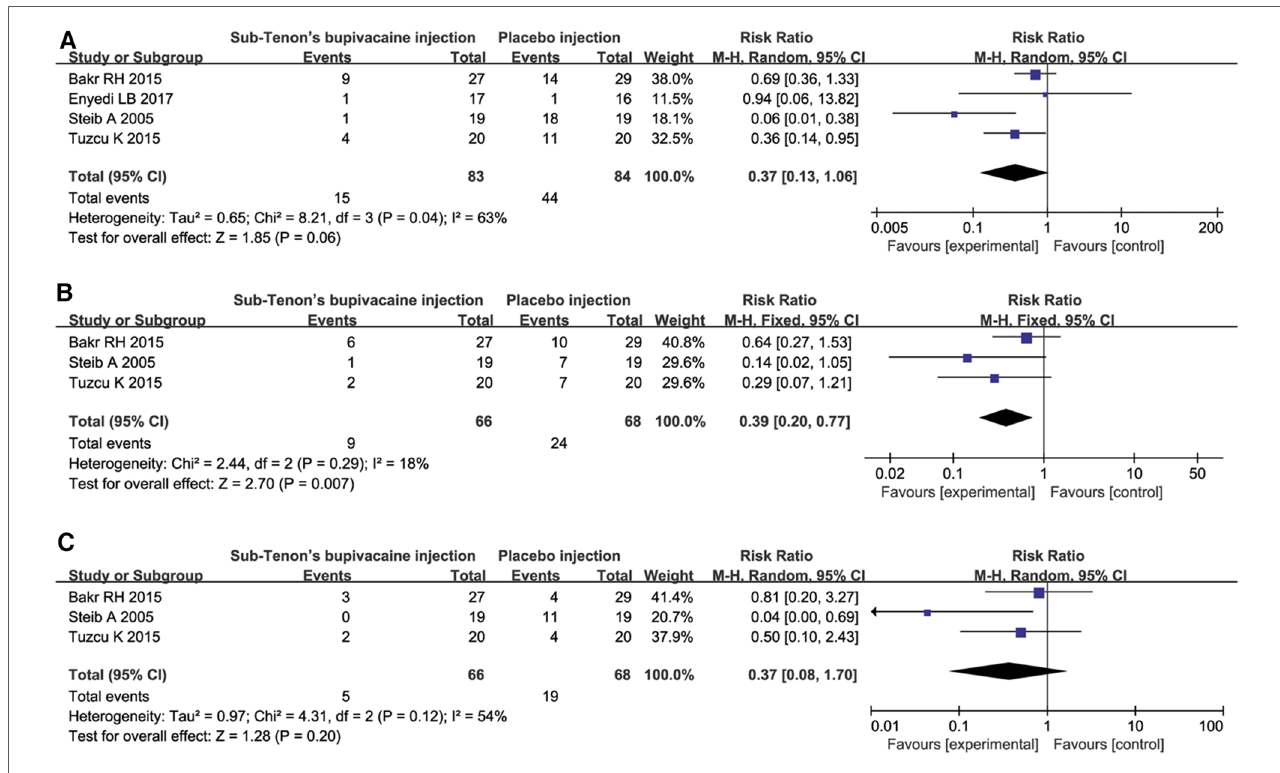
FIGURE 5 Incidence of PONV ( A ), vomiting ( B ) and nausea ( C )